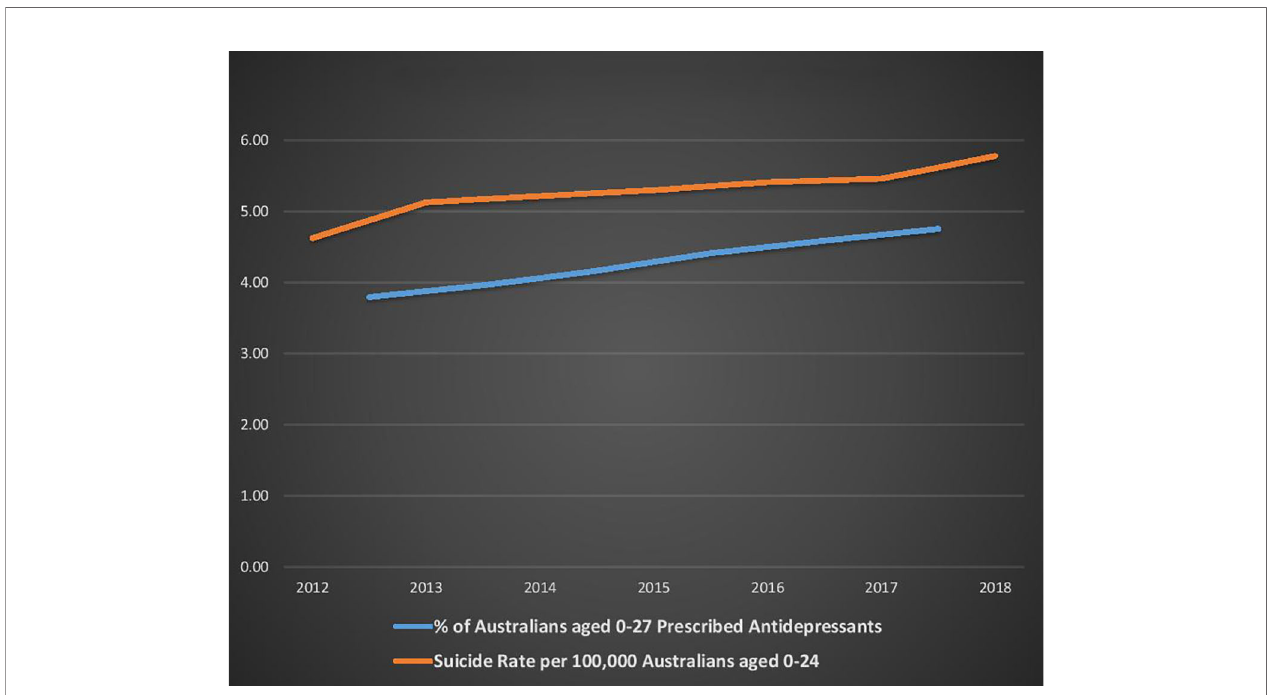
FIGURE 4 | Antidepressant use and suicide rates for young Australians from 2012 to